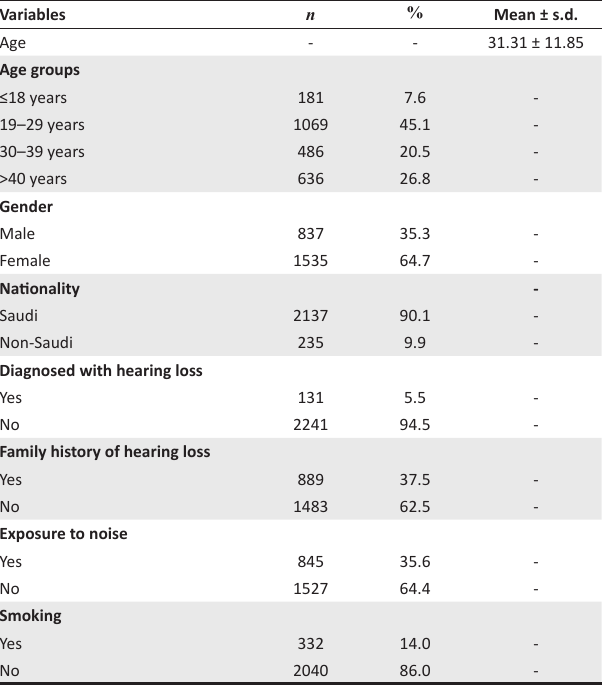
TABLE 2: Demographic characteristics of the sample ( n =